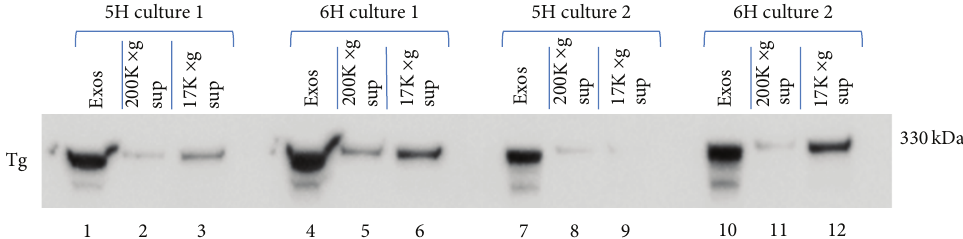
Figure 3: SDS-PAGE and Tg Western blot of samples from different stages of exosome isolation by ultracentrifugation: 17,000 × g supernatant, 200,000 × g supernatant, and 200,000 × g (exosome pellet) from samples of 5H (lanes 1–3 and 7–9) and 6H media (lanes 4–6 and 10–12) collected from confluent cultures of FRTL-5 cells incubated for 48 hours. 15 𝜇 L samples of resuspended isolated exosomes were loaded for 5H culture 1 and 6H culture 1, while 7 𝜇 L samples were loaded for both 5H culture 2 and 6H culture 2. Due to the limited number of lanes in each gel, lanes numbered 1 through 6 and 7 through 12 were run on separate gels. Protein concentrations of resuspended exosome samples were nearly identical in both of the two 5H cultures and both of the 6H cultures. Western blots were treated with a monoclonal anti-human-Tg antibody and developed using SuperSignal West Pico. “Exos” = exosomes (i.e., 200,000 × g pellet).